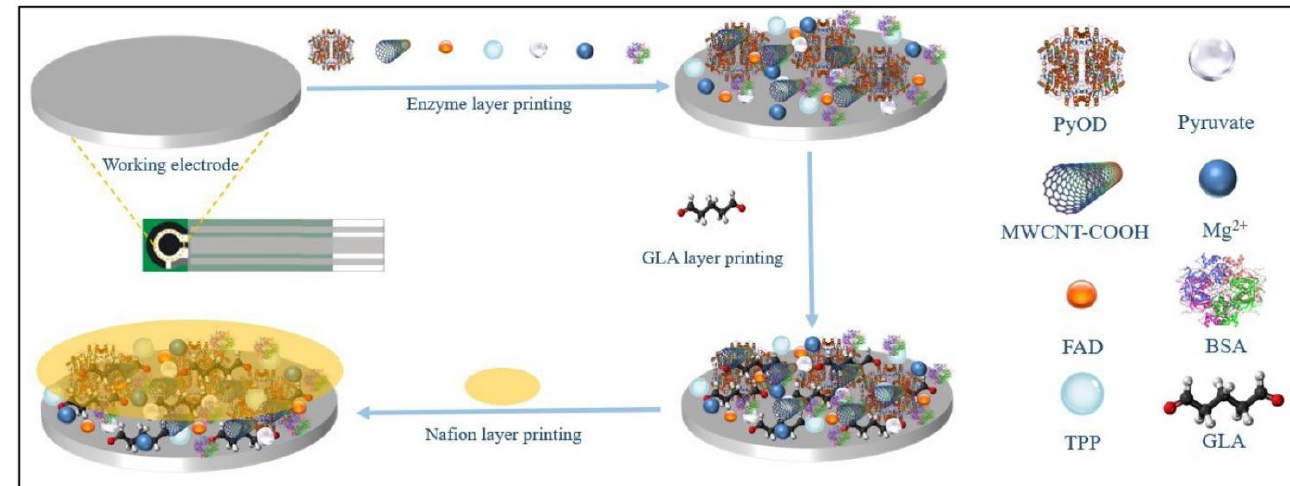
Figure 6. Graphic illustration of the functionalization process of the screen-printed electrodes. Three kinds of inks were sequentially inkjet-printed, layer by layer, on the working electrode. The enzyme layer with biological entities was printed in the first layer, followed by the glutaraldehyde (GLA) layer to form a cross-linking layer. Finally, the Nafion layer was printed to act as a protective layer to encapsulate the sensor. Reprinted with permission from [70].